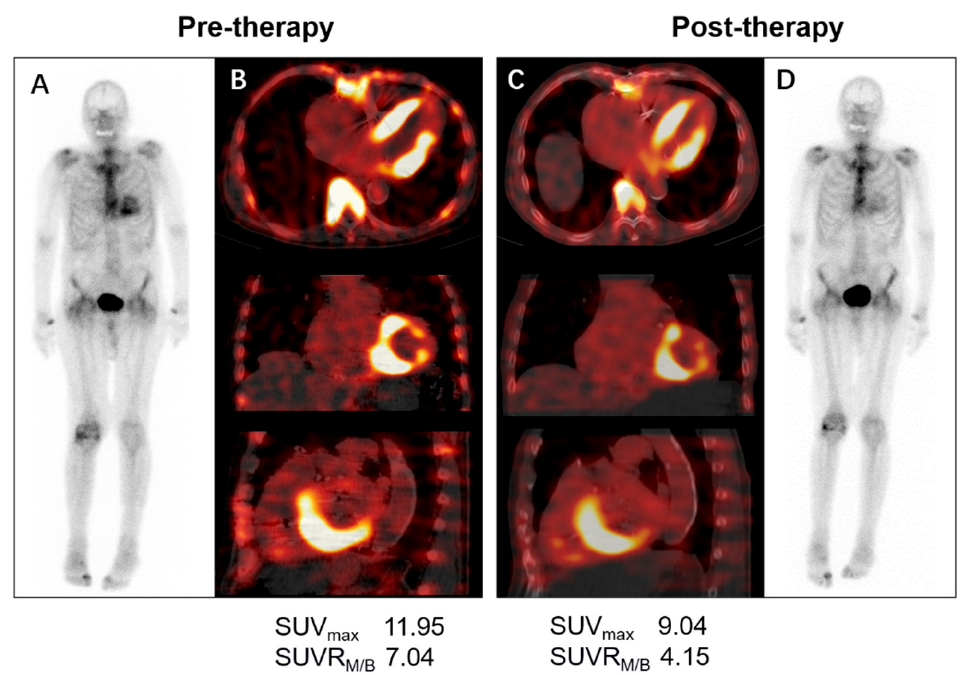
Figure 4. Serial 99m Tc-DPD whole-body planar and SPECT/CT scans in a patient with wild-type ATTR receiving 6 months of 61 mg tafamidis. The visual cardiac uptake (Perugini grade 2) was unchanged before ( A ) and after tafamidis therapy ( D ), whereas quantitative measurement of left ventricular uptake on axial, coronal, and sagittal SPECT/CT images before ( B ) and after tafamidis ( C ) showed a decrease in SUV max (11.95 vs. 9.04 g/mL) and SUVR M/B (7.04 vs. 4.15). SPECT/CT = single-photon emission tomography/computed tomography; ATTR = transthyretin amyloidosis; SUV max = maximum standardized uptake value; SUVR M/B = SUV max for myocardial to background (blood pool) ratio.